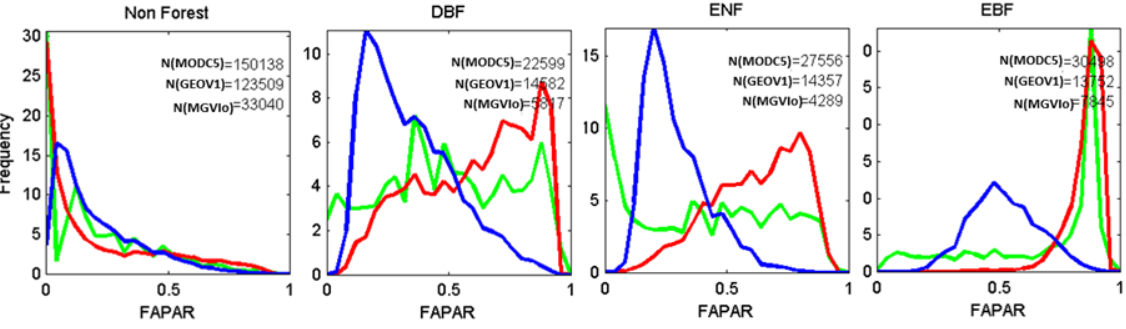
Figure 9. Distribution of FAPAR product value for the four main biome types: Non-Forest, Deciduous Broadleaf Forest (DBF), Evergreen Needleleaf Forest (ENF), Evergreen Broadleaf Forest (EBF). GEOV1 (red), MGVIo (blue) and MODC5 (green). For each product, N is the number of observations that were used to compute the distribution. Computation is performed over the BELMANIP2.1 sites (49 × 49 km 2 ), during the periods defined in Table 2, and for the original temporal sampling.